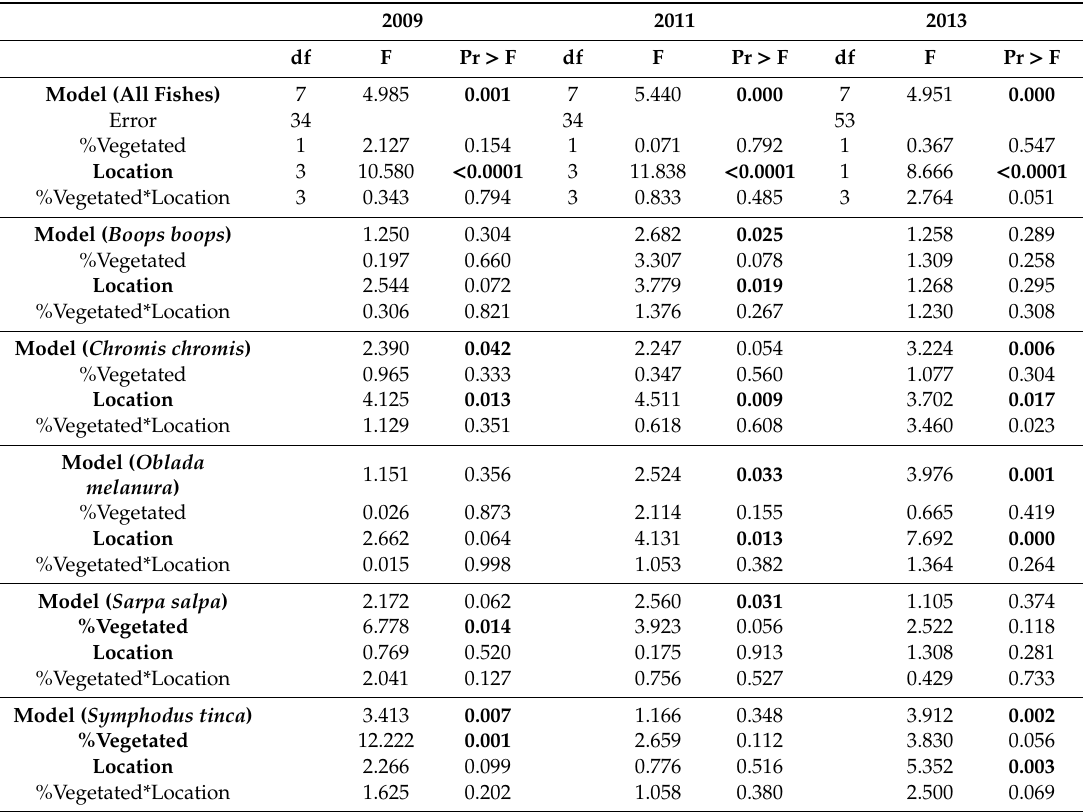
Table 2. Analysis of covariance (ANCOVA) results examining within-year variability related to the percentage of total vegetated Caulerpa and Posidonia habitat (%vegetated) and location (site) for density (fish m − 2 ) of all fishes and the five most abundant species. Significant values ( p < 0.05) and factors for which significance was observed in a given year are indicated in bold. Interactions (%Vegetated*Location) between factors that were significant in at least one given year are additionally included below. All other interactions were non-significant ( p >